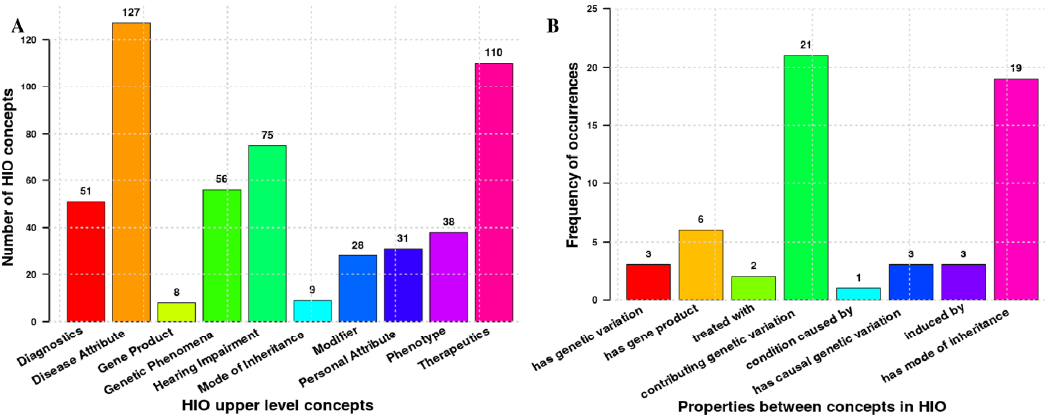
Figure 3. Summary statistics of current concepts and properties in the current HIO. Numbers at the top of bars represent the number of di ff erent HIO sub-classes topologically linked to upper level classes ( A ) and the occurrence frequency of a given property or association in the ontology ( B ). Note that ‘contributing genetic variation’ is used as the short hand label for the 'gene carrying contributing genetic variation' property and ‘has causal genetic variation’ for the 'condition has causal or contributing genetic variation' property.